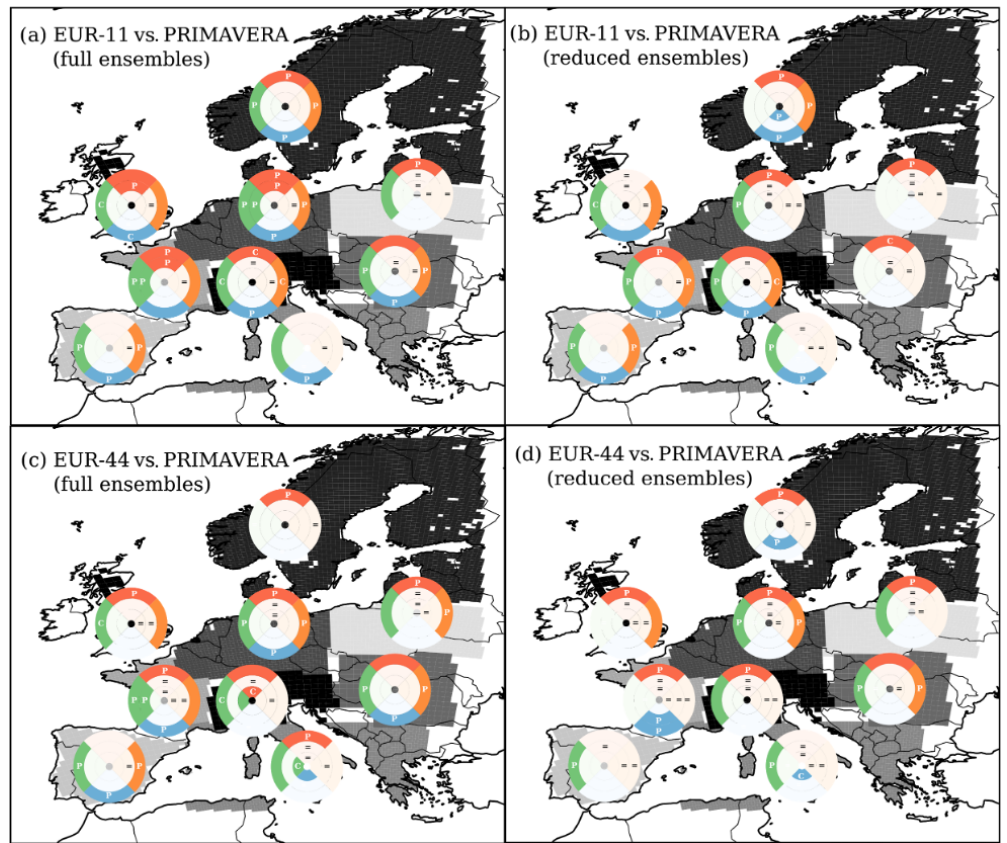
Figure 8. Map using the method described in Fig. 1. For each region, season (clockwise from the top: summer, autumn, winter, spring; see right-hand side of Fig. 1), and precipitation intensity interval: low-precipitation rates (inner part), moderate-precipitation rates (middle part), high-precipitation rates (outer part). A colour indicates that CORDEX and PRIMAVERA are significantly different; a “P” or “C” letter indicates that PRIMAVERA or CORDEX is closer to observations, respectively; an “ = ” sign indicates that both ensembles are close to observations. (a) Map for the full PRIMAVERA and EUR-11 ensembles (listed in Tables 1 and 2). (b) Map with reduced PRIMAVERA and EUR-11 ensembles using GCMs of the same family (coloured in Tables 1 and 2). (c) Map for the full PRIMAVERA and EUR-44 ensembles (listed in Tables 1 and 2). (d) Map with reduced PRIMAVERA and EUR-44 ensembles using GCMs of the same family (coloured in Tables 1 and